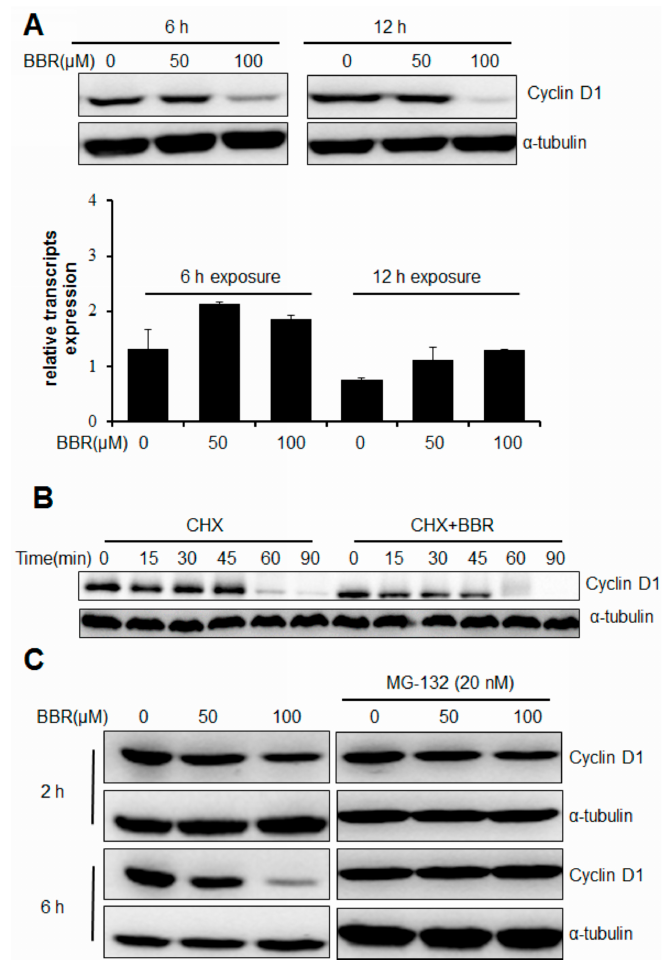
Figure 2. Berberine inhibits Cyclin D1 expression in HepG2 cells via post-translational control. ( A ) qPCR was used to detected the mRNA transcript of Cyclin D1 with GAPDH as internal control. No mRNA changed while Cyclin D1 protein was reduced by berberine; ( B ) Cells were treated with berberine in the presence of 150 µg/ml Cycloheximide. Reduced half-life in berberine-treated cells were found; ( C ) Cells were treated with berberine in the presence of 20 nM MG-132. Cyclin D1 was detected by immunoblotting with α -tubulin as internal control.